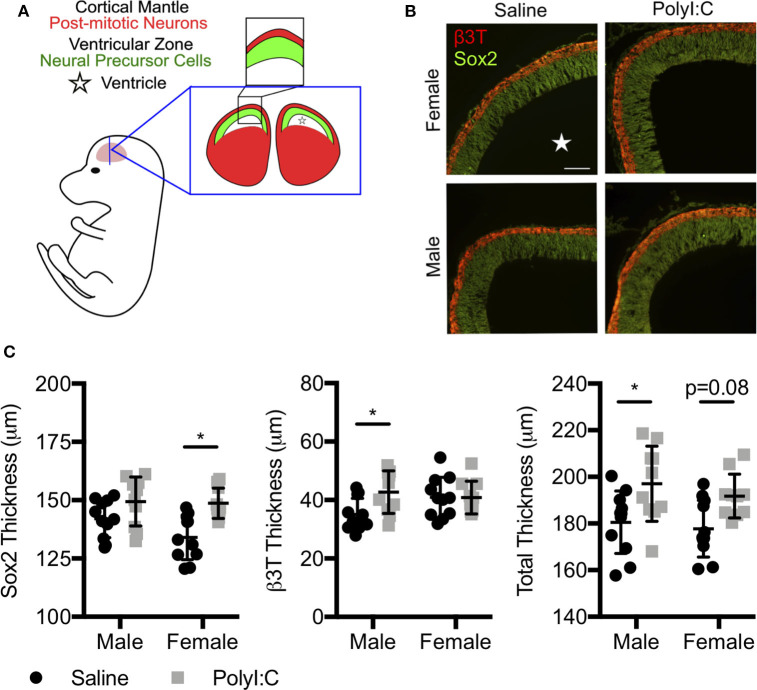
Prenatal exposure to PolyI:C prompts changes in cortical architecture. Dams were injected with either saline or PolyI:C on E8.5, and whole fetal brains were collected 1 week later. (A) Schematic depiction of the layers of the rat fetal cortex at E15.5. (B) Coronal sections of the cortex at E15.5 were stained for β3T (red) and Sox2 (green) to delineate the CM and VZ, respectively. (C) Measurements showing total cortical thickness and thickness of the CM and VZ in male and female fetuses. Graphs represent means ± SEM. A star () denotes the ventricle. Statistical analyses were performed using two-way analysis of variance and Sidak's multiple comparison. Data are represented as mean ± SEM and asterisks denote statistical significance (*P < 0.05; N ≥ 10 fetuses per sex from at least three dams per group). Scale bar = 100 μm.